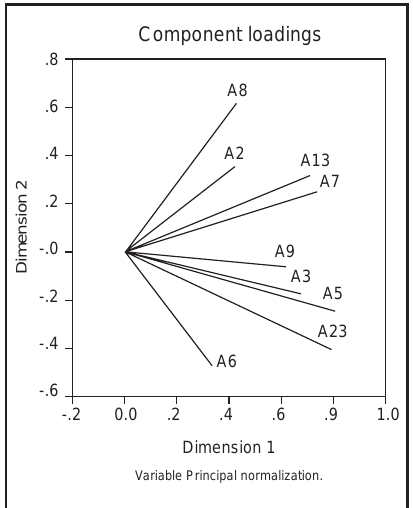
Figure 1: Component loadings for RMDQ items after removal of items not contributing to the measurement of functional